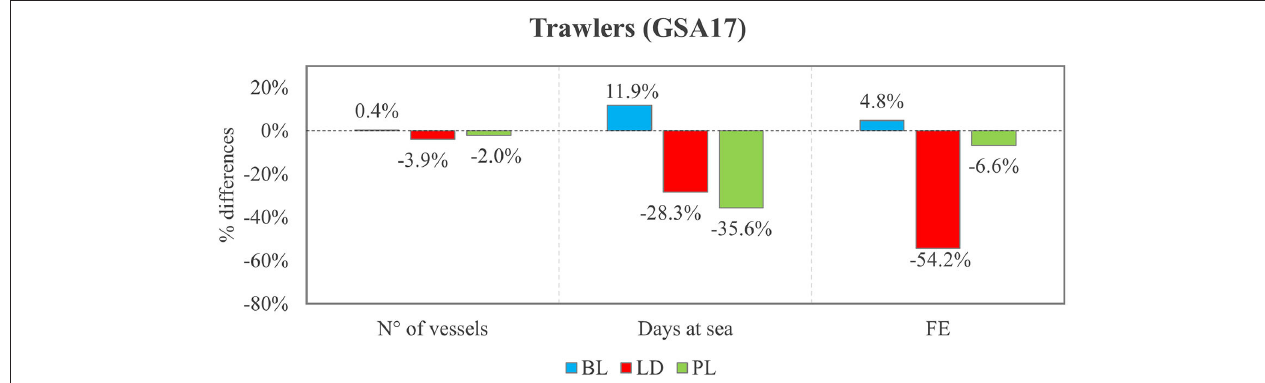
FIGURE 3 | Percentage differences between 2019 and 2020 during the three periods (BL: before lockdown, LD: lockdown, and PL: post-lockdown) considering the number of vessels, the days at sea and the fishing effort (FE) of the GSA17 trawling fleet.